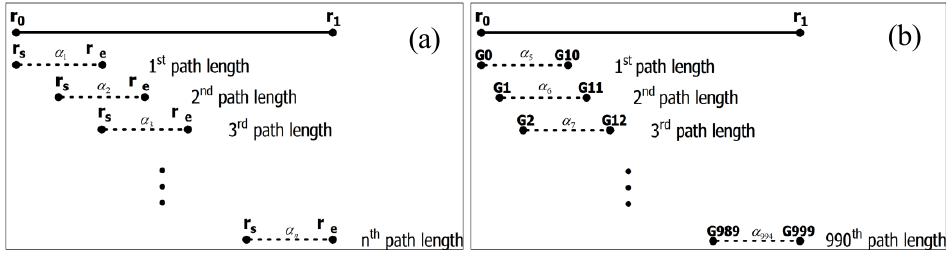
Figure 1. ( a ) The Kim et al.’s method; ( b ) the SSCC method, assuming α i = 0 ( i = 0, 4; 995,999).